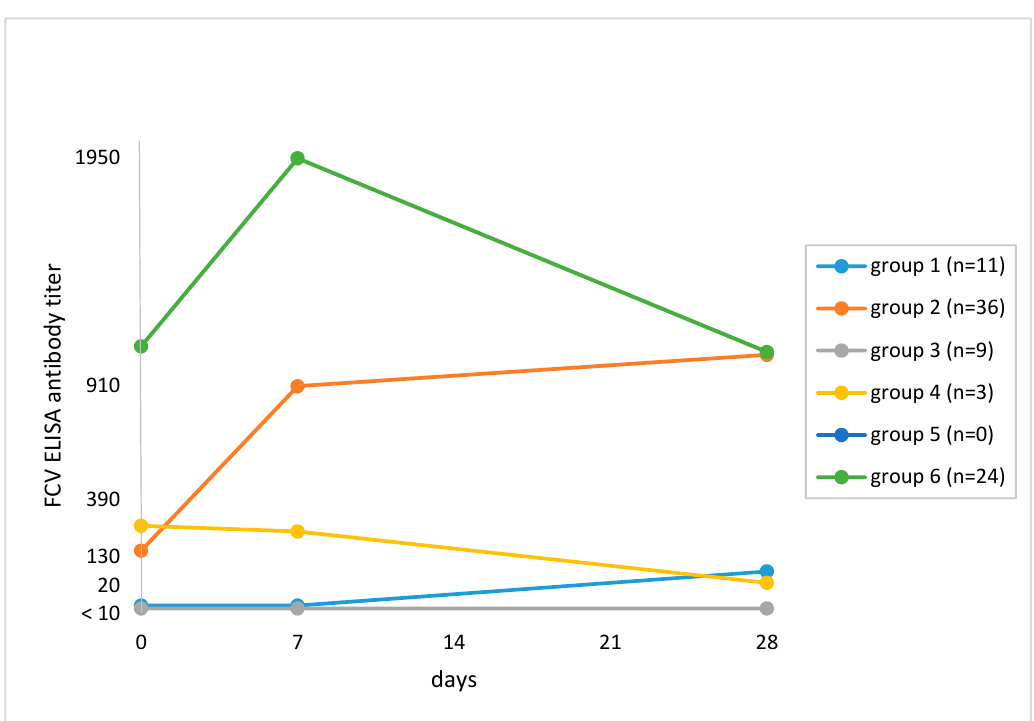
Figure 2. Grouping of cats based on median feline calicivirus (FCV) antibody titers on Day 0 and changes in titer after vaccination against FCV in ELISA. The numbers of cats at each time point are given in Section 2.2. Study protocol. Group 1: Titer < 20 on Day 0 and subsequent increase in titer ( n = 11; 13.3%). Median titers: Day 0, < 20; Day 7, < 20; Day 28, 60. Group 2: Titer ≥ 20 on Day 0